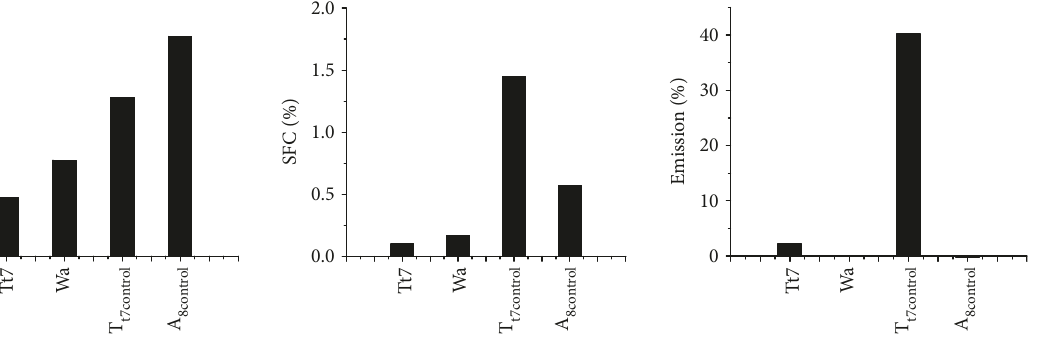
Figure 20: Sensitivity analysis of the ramjet mode at design point.